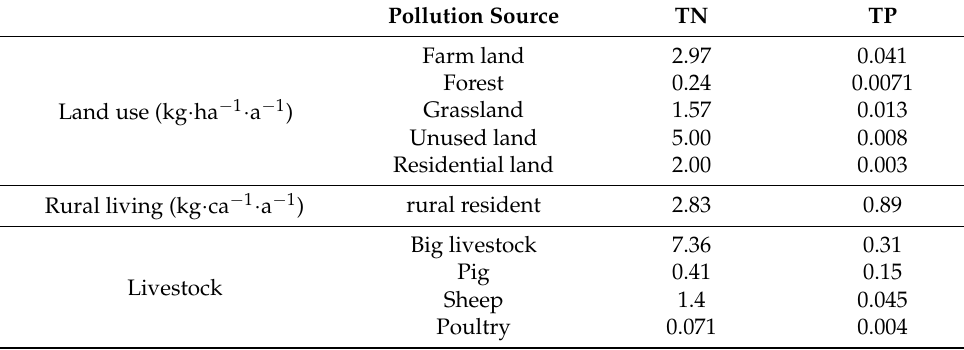
Table 2. Export coefficients for different pollution sources. Pollution Source